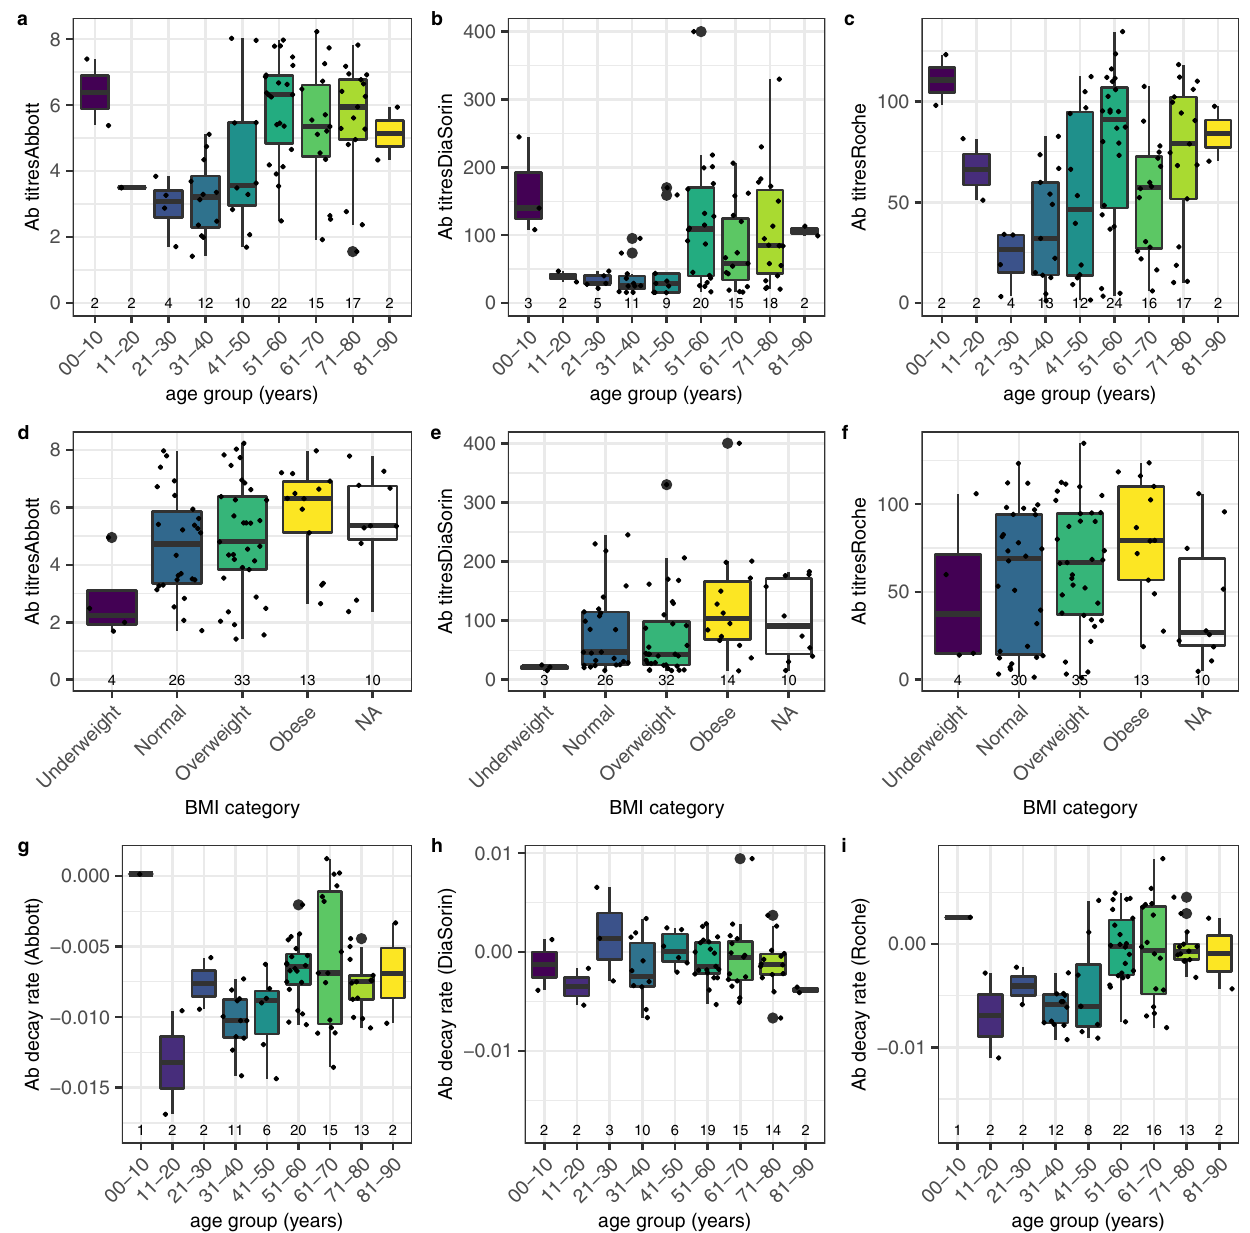
Fig. 4 Association between antibody titres and antibody decay rate with age group and BMI category. Antibody titre distribution by age group ( a – c ) and by BMI ( d – f ) and the estimated antibody decay rate distribution by age group ( g – i ) according to Abbott, DiaSorin, and Roche assays, respectively. In all panels, bold is the median, box is the interquartile range, whiskers de fi ne the range having removed the outliers; outliers are de fi ned as observations further from 1.5 times the interquartile range. The association analysis was conducted on the subjects identi fi ed as exposed to SARS-CoV-2 according to the baseline ground truth de fi nition. The numbers at the bottom of each panel represent the number of subjects in each category. Within-household SARS-CoV-2 transmission . Using the base- age using the Abbott and Roche assays (Fig. 4; Supplementary Table 6). We found no statistically signi fi cant differences in the line ground truth de fi nition, we identi fi ed 1,118 households in average antibody decay rate between BMI categories (Supple- Vo ’ with known infection status for all household members mentary Table 6). However, we observed a signi fi cant association (Supplementary Table 9). Overall, 5.01% (95% CI 3.81 – 6.46%) of between the decay rate of the antibodies quanti fi ed by Roche and the households in Vo ’ experienced at least one SARS-CoV-2 the BMI among symptomatic infections, with 0.0003 decrease in infection. The household size distribution, along with the antibody decay rate per unit increase in BMI (Supplementary observed attack rates and frequency of SARS-CoV-2 infections by Table 6). Additional results are discussed in Supplementary age group and household size are shown in Supplementary Fig. 2. Note 1, and we report the association between symptoms Using the model proposed by Fraser et al. 24 (summarised in Supplementary Methods, section 4) we found that models occurrence and comorbidities in Supplementary Table 7 and the allowing for overdispersion in the offspring distribution (model association between symptoms occurrence and medical treatment in Supplementary Table 8. NATURE COMMUNICATIONS|